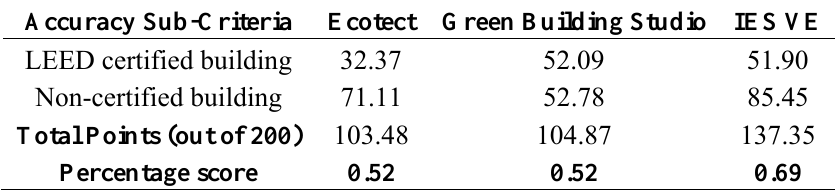
Table A12. Re-evaluation: accuracy criterion calculations for the top three BEM